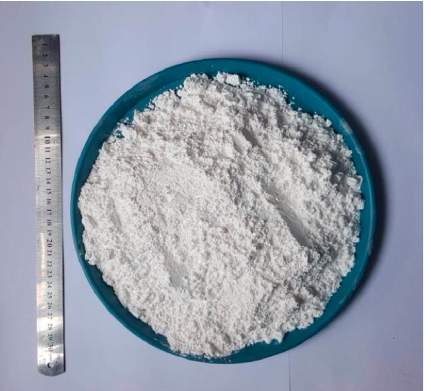
Figure 4: Aspha-min